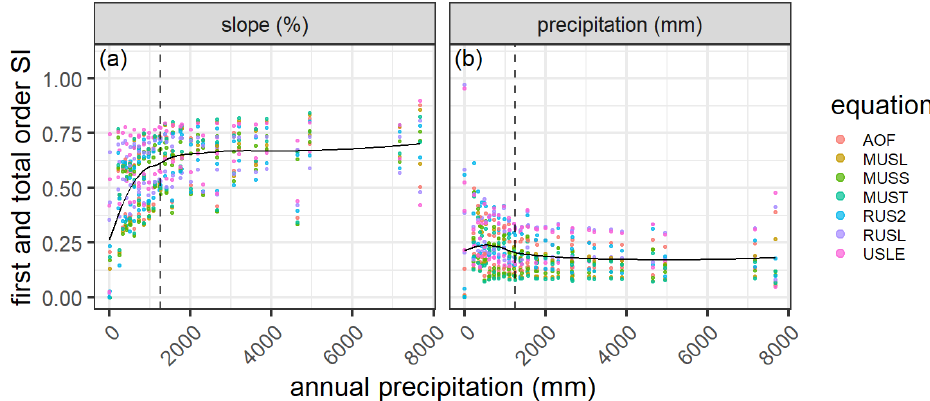
Figure 5. First-order and total-order sensitivity indices (SIs) for (a) slope steepness (%) and (b) precipitation (mm). The dashed vertical line illustrates median annual precipitation at all tested locations (1248mm).